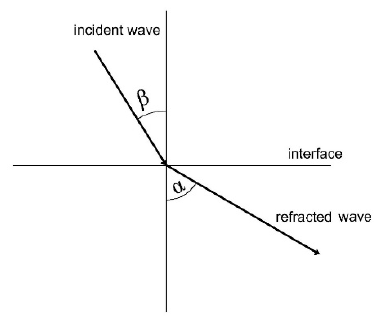
Figure 1. Snell’s law for refraction angle analysis.